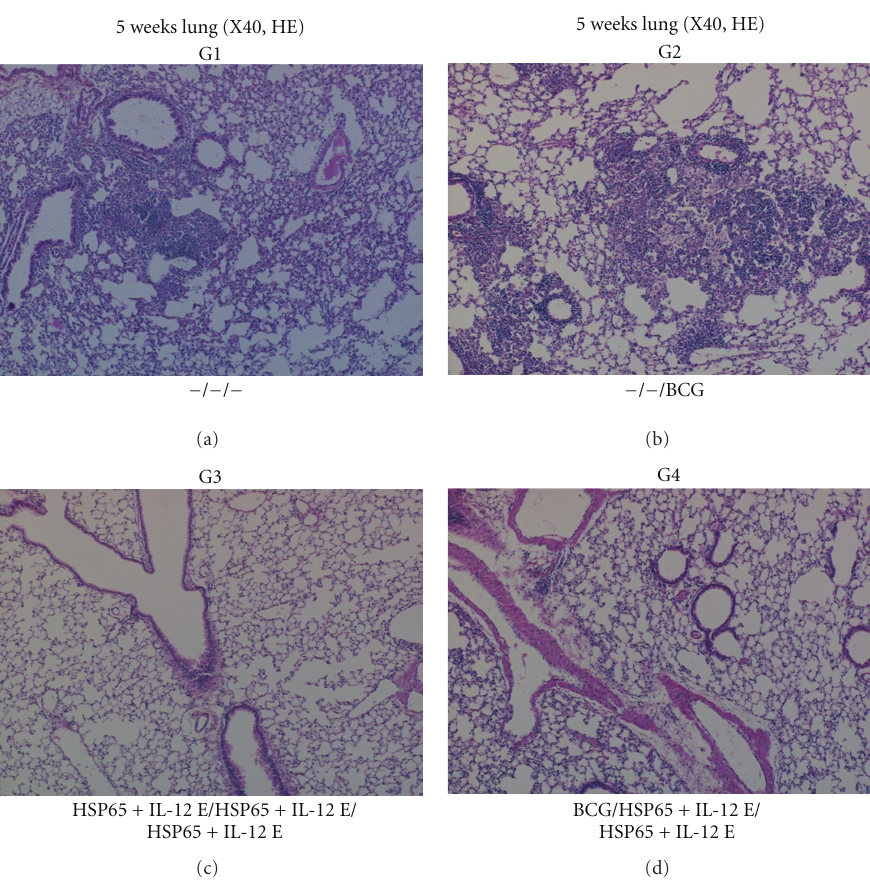
Figure 6: Histopathological analysis of vaccinated mice 5 weeks after M. tuberculosis challenge. Representative photomicrographs of lung tissue sections harvested from the G1 naive control group, G2 (BCG alone) group, G3 group (DNA/DNA/DNA), and G4 group (BCG/DNA/DNA) are shown (5 weeks after M. tuberculosis challenge, hematoxylin and eosin staining, × 4 objective). There was much infiltration of mononuclear cells and extensive parenchymal destruction by large, poorly demarcated granuloma in the lungs from the G1 (naive control) group and G2 (BCG alone) group. In the G3 (DNA/DNA/DNA) group and G4 (BCG/DNA/DNA) group, there was less inflammation, and only a few granulomas were